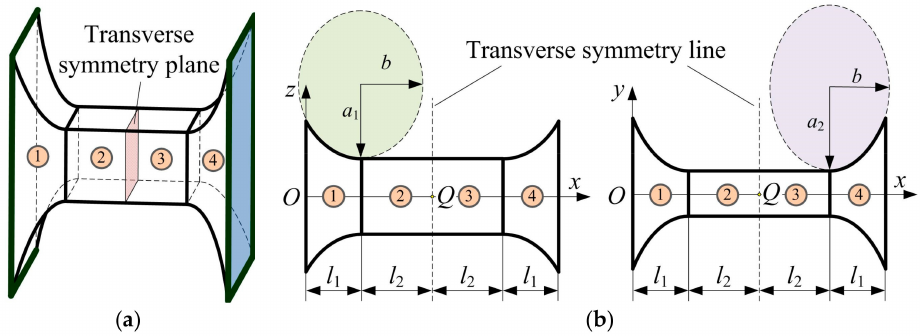
Figure 4. Four-segment two-axis elliptical-arc-filleted flexure hinge: ( a ) Three-dimensional view; ( b ) Geometric parameters and two non-identical cutout profiles.